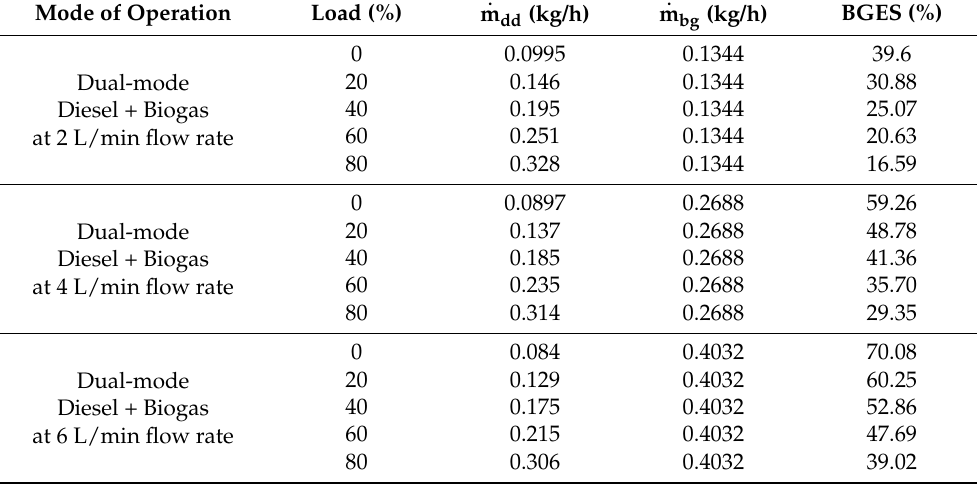
Table 8. Mass fraction of